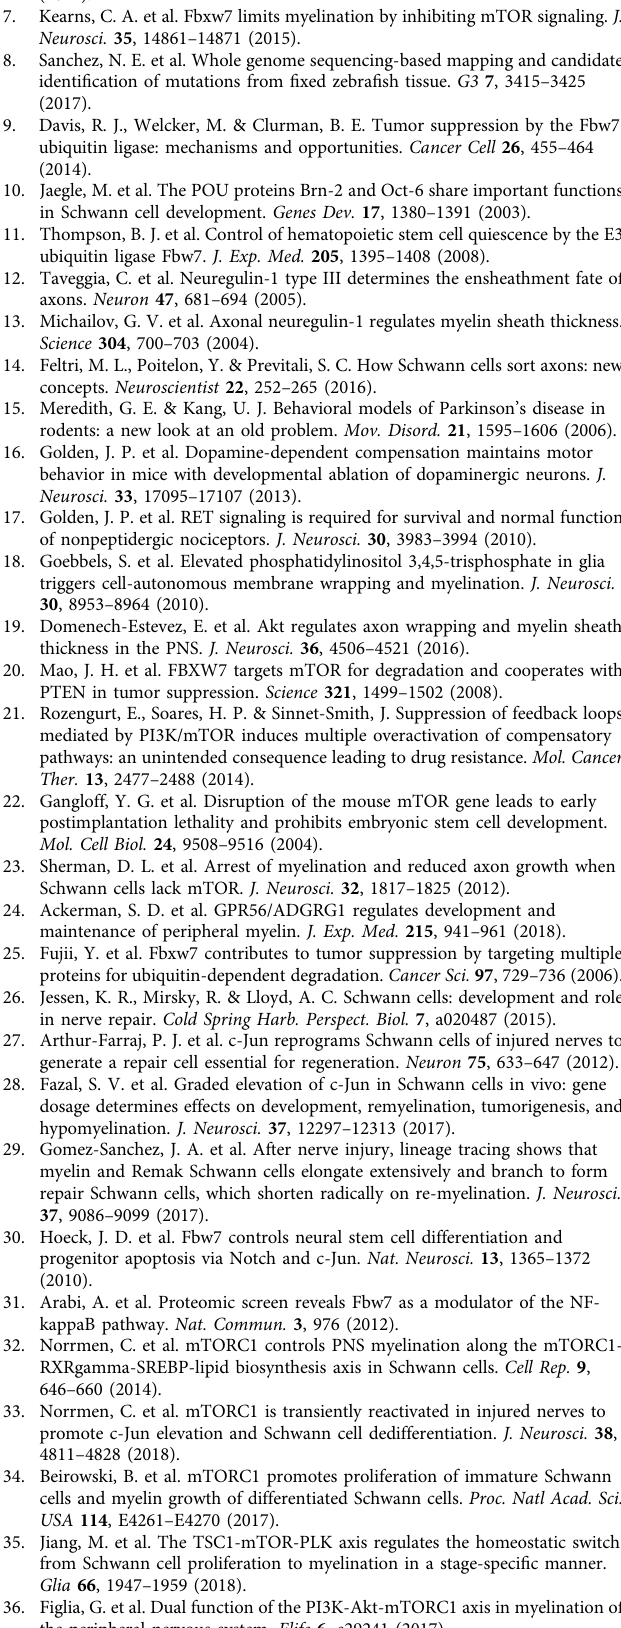
Fig. S3. All error bars depict RQmax and RQmin, which represent the maximum and minimum limits of possible RQ values based on the standard error of the Δ Ct values. The gray line at y = 1 represents the